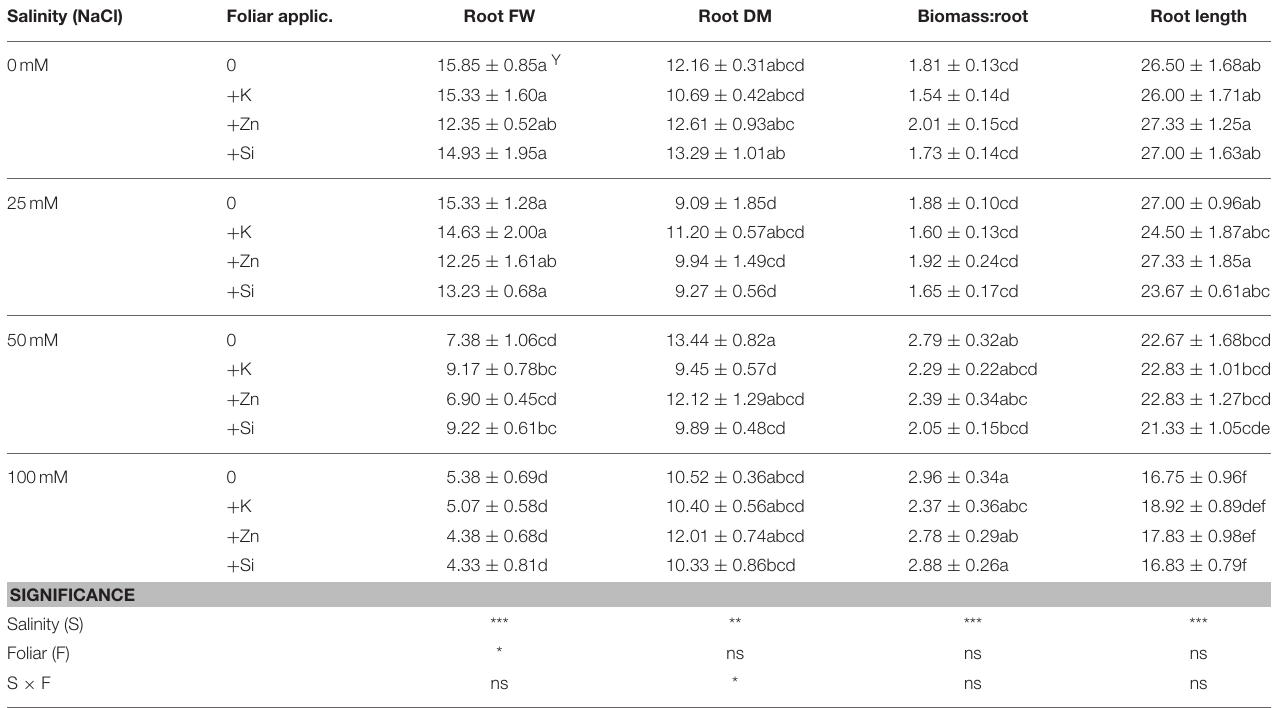
TABLE 2 | Effect of salinity levels (0–25–50–100mM NaCl) and foliar applications (no foliar, K, Zn, and Si) on lavender root fresh weight (FW; g/plant), root dry matter (DM; %), biomass:root ratio, and root length (cm) in plants grown hydroponically in perlite. Salinity (NaCl) Foliar